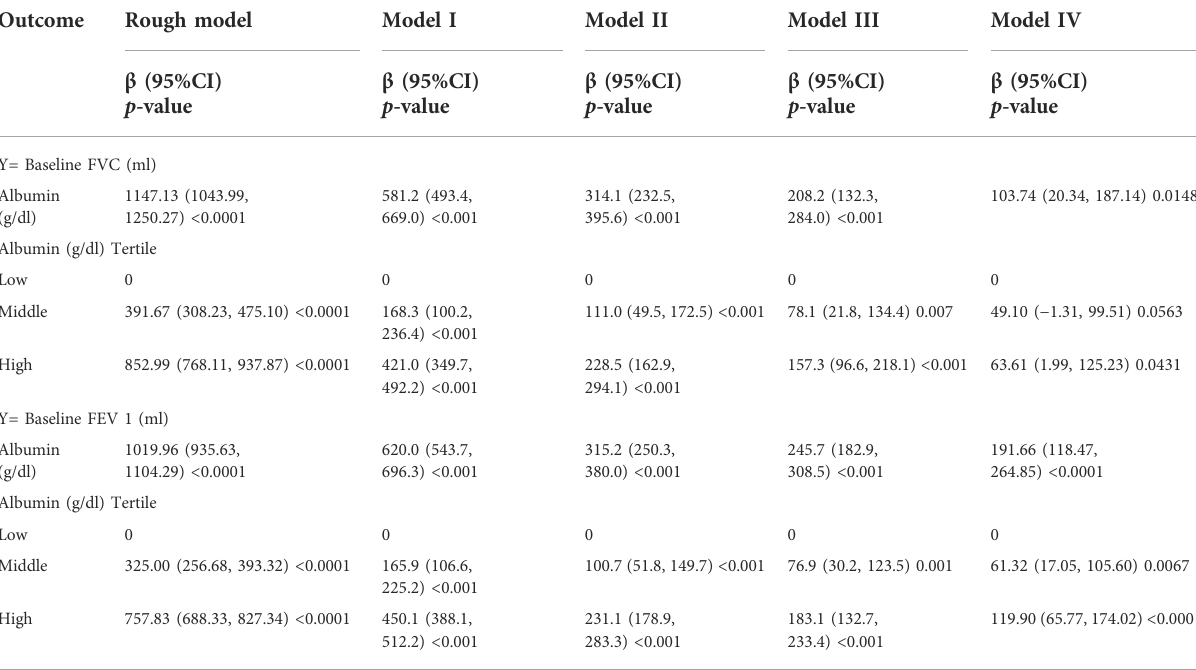
TABLE 3 Relationship between serum and serum albumin and Pulmonary Function (multiple regression equation analysis).